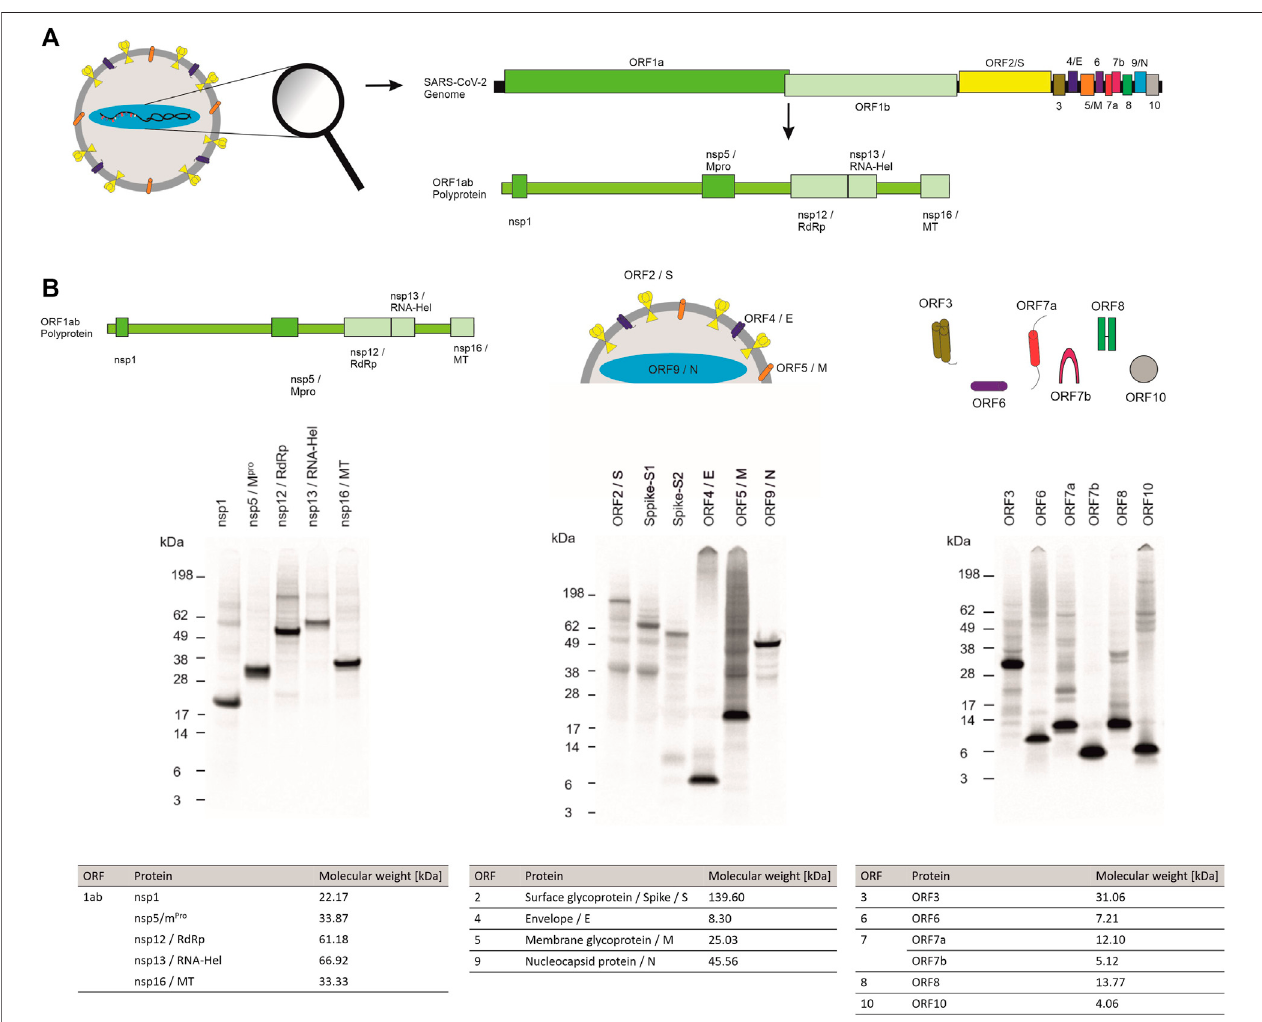
FIGURE1| Cell-freesynthesisofSARS-CoV-2proteinsinaCHOcell-freesystem. (A) Schematic fi gureshowingtheSARS-CoV-2virusparticleanditsstructureas well as the coding sequences of the genome. (B) Qualitative analysis of cell-free synthesized SARS-CoV-2 proteins by autoradiography. Autoradiograph showing 14 C-leucine labeled proteins synthesized in a CHO system from the translation mixture